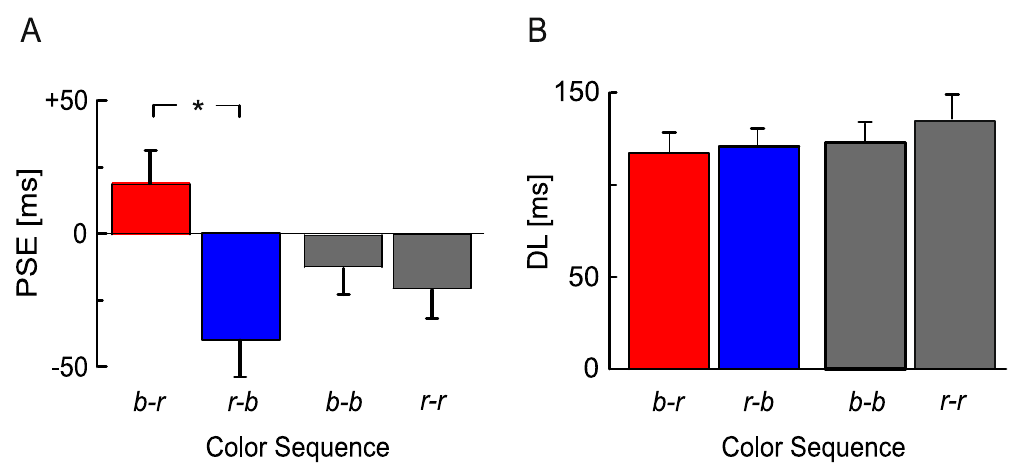
Figure 3. Mean point of subjective equality (PSE; panel A) and mean difference limen (DL; panel B) as a function of color sequence. Error bars indicate + / − 1 standard error of the mean. N = 13. * Indicates statistically significant differences ( p <